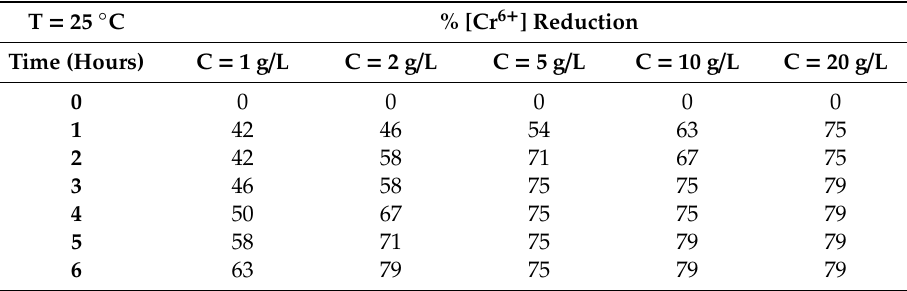
Table 1. Chromium removal percentage vs number of treatment cycles with zeolite X at T = 25 ◦ C and pH = 5.5 for the zeolite X concentrations: (i) 1 g / L, (ii) 2 g / L, (iii) 5 g / L, (iv) 10 g / L and (v) 20 g / L.